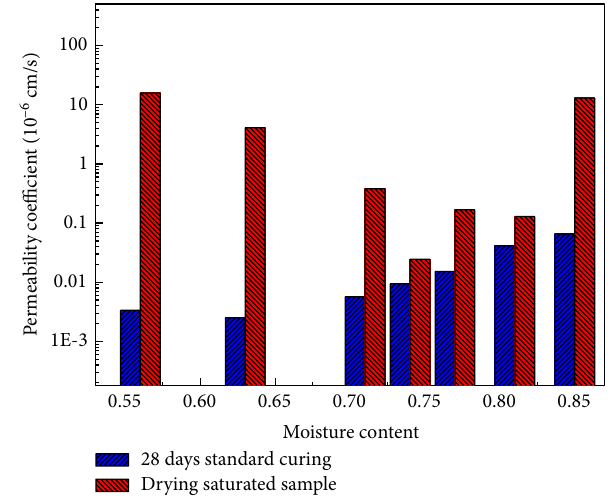
Figure 4: Permeability coefficient of solidified sludge with different initial moisture content.